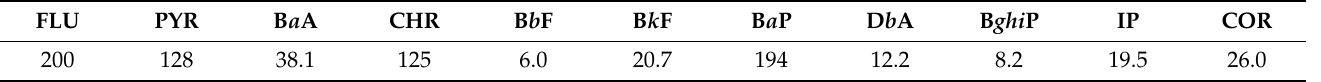
Table 10. Concentrations of PAH in airborne particulate matter from bush fire (mg/kg). Data from